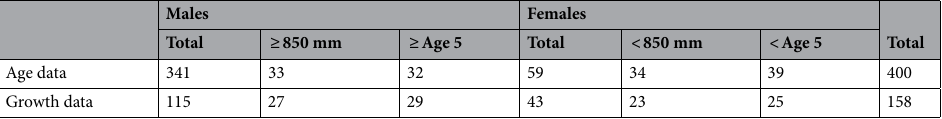
Table 1. Details of barramundi samples used in this study, showing the number of individuals classified into the life history types of interest. Table shows the number of individuals per group for which age data were available, and the subset of individuals subjected to growth